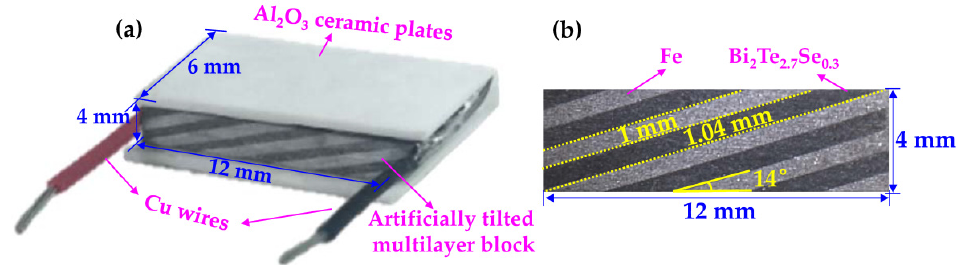
Figure 4. ( a ) Packaged Fe/BTS ATMTD; ( b ) cross-sectional image of artificially tilted multilayer block.